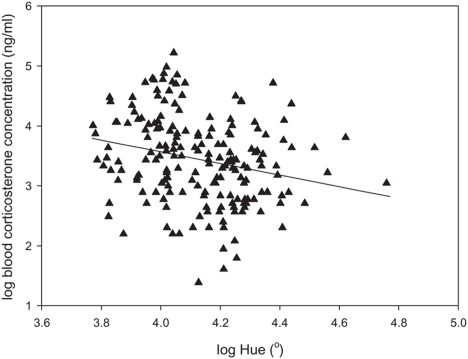
Correlation between basal blood corticosterone levels and the hue of the ventral colouration.The data were loglog transformed to meet the assumptions of the statistical analyses.